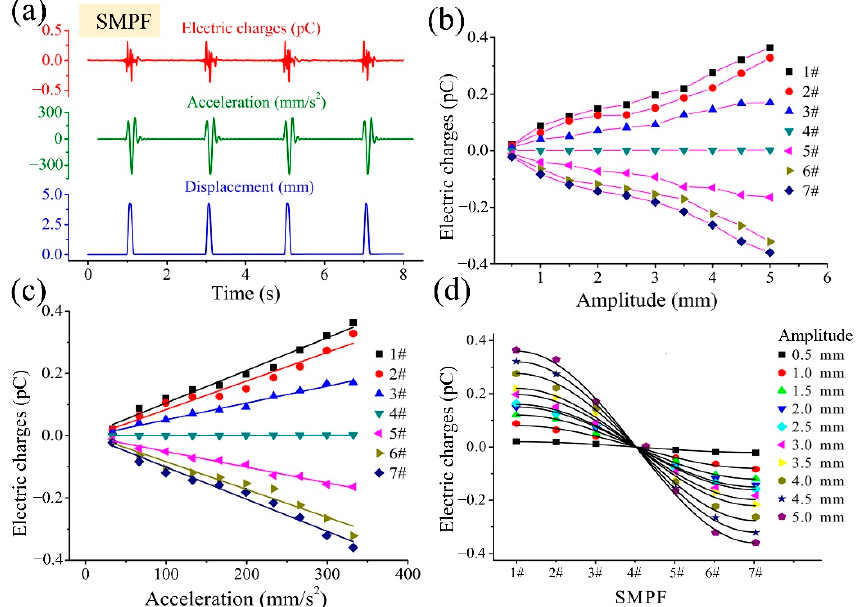
Figure 4. ( a ) The displacement and linear acceleration of the shell, as well as the output charges of SMPF1#. ( b ) The relation between the output charges of the seven SMPF sensors and the displacement amplitude of the shell. ( c ) The relation between the seven SMPF output charges and the shell linear acceleration. ( d ) The output charges of the seven SMPF sensors at different amplitudes of impact oscillation.